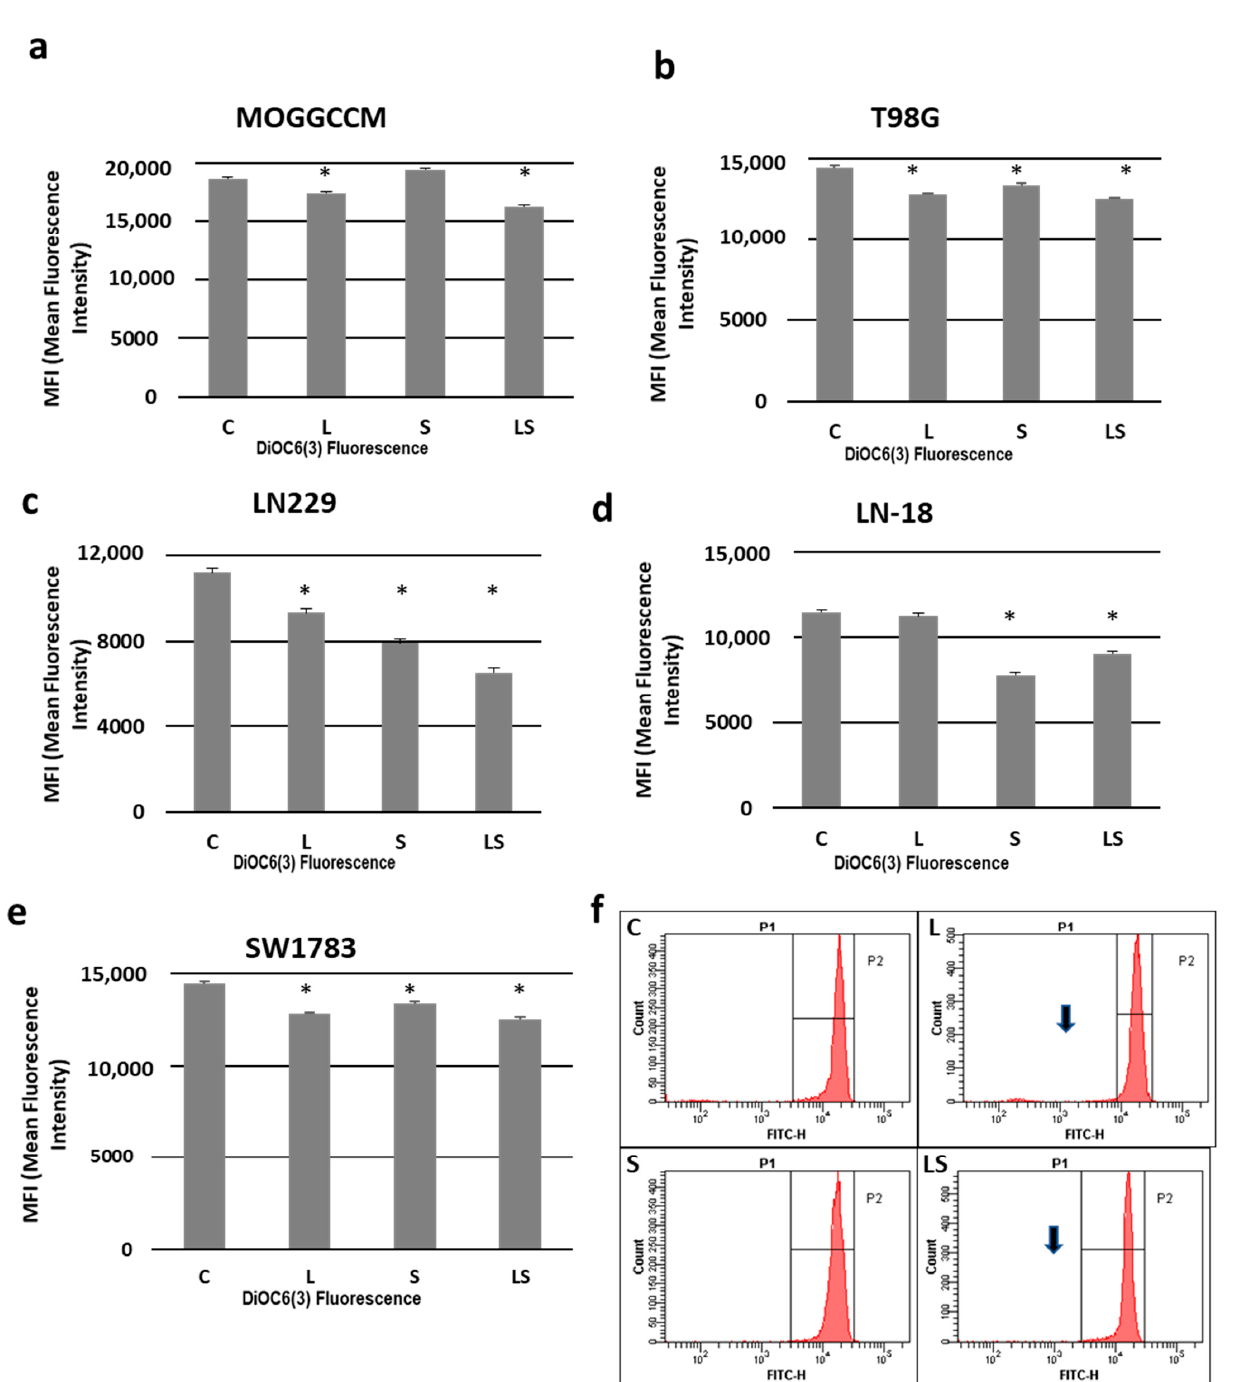
Figure 5. Effect of lensoside A β (L) and sorafenib (S) applied alone or in combination (LS) on the mitochondrial membrane potential (MMP) expressed as DiOC6(3) mean fluorescence intensity as diagrams ( a – e ) in anaplastic astrocytoma (MOGGCCM, LN229, SW1783; ( a , c , e )) and glioblastoma multiforme cells (T98G, LN-18; ( b , d )). ( f ) Representative gates (histograms) of the MOGGCCM cells (diminished MMP indicated by arrows). C—control; * p <